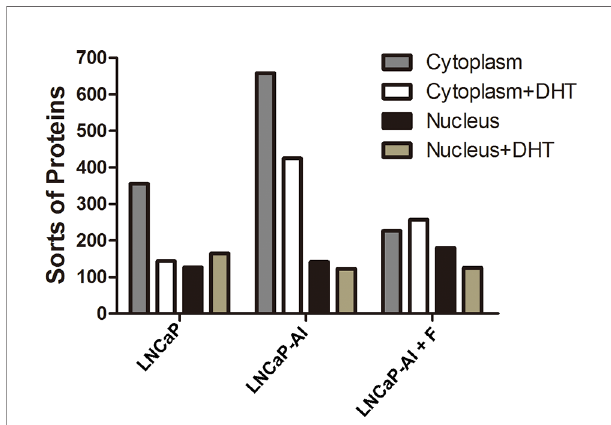
FIGURE 3 | Number of proteins in AR pull-down produces among the three PCa cell lines. Three PCa cell lines were seeded for 24 h before treated with or without 10 nM DHT and harvested at the indicated time points (72 h for LNCaP cells, 48 h for LNCaP-AI and LNCaP-AI+F cells). Cell lysates of cytoplasmic and nuclear proteins were immunoprecipitated using AR McAb and identi fi ed by